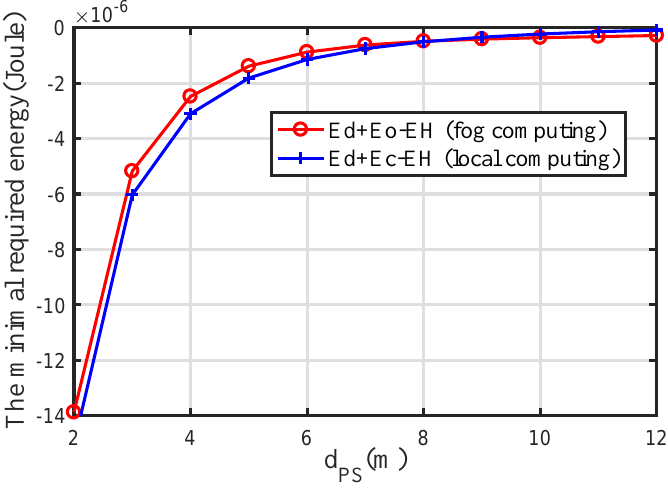
Figure 4. Performance comparison of the two computing modes versus d PS .